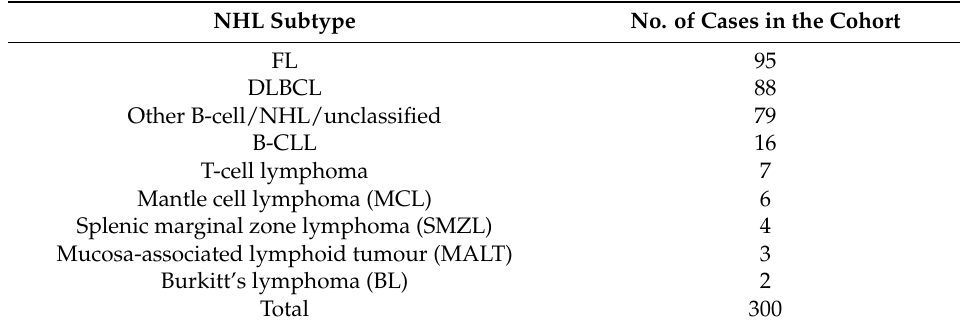
Table 1. Retrospective Genomics Lymphoma Project-non-Hodgkin lymphoma (GLP-NHL) cohort comprising of different NHL subtypes and the number of cases for each